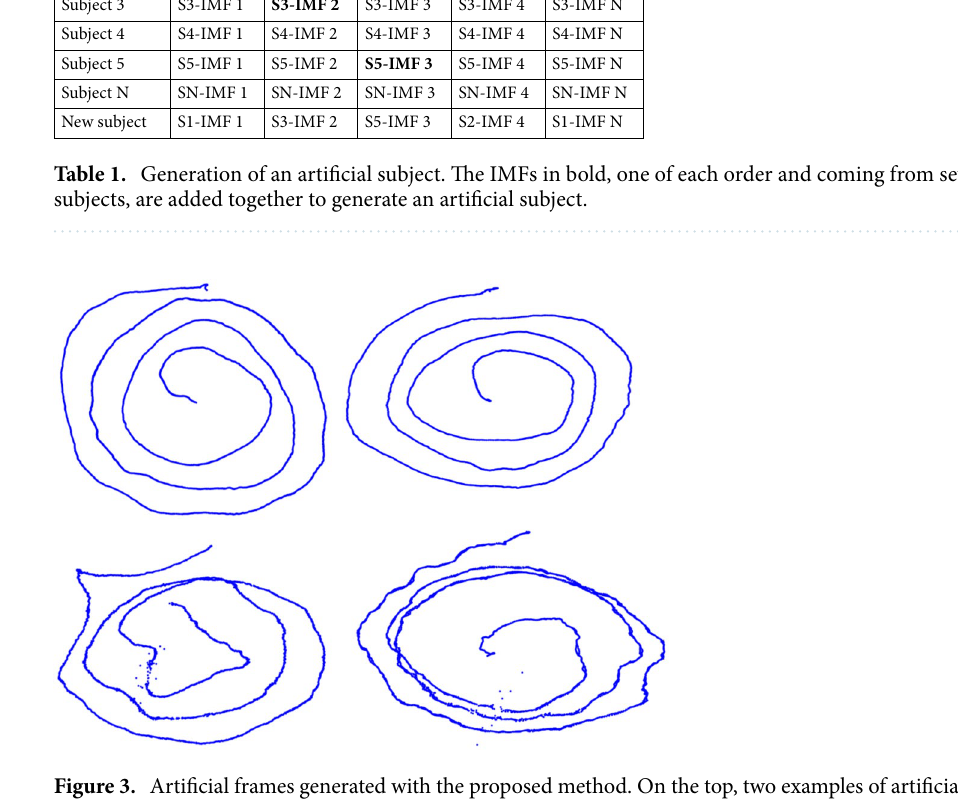
Figure 3. Artificial frames generated with the proposed method. On the top, two examples of artificial CT samples; On the bottom, two examples of artificial ET